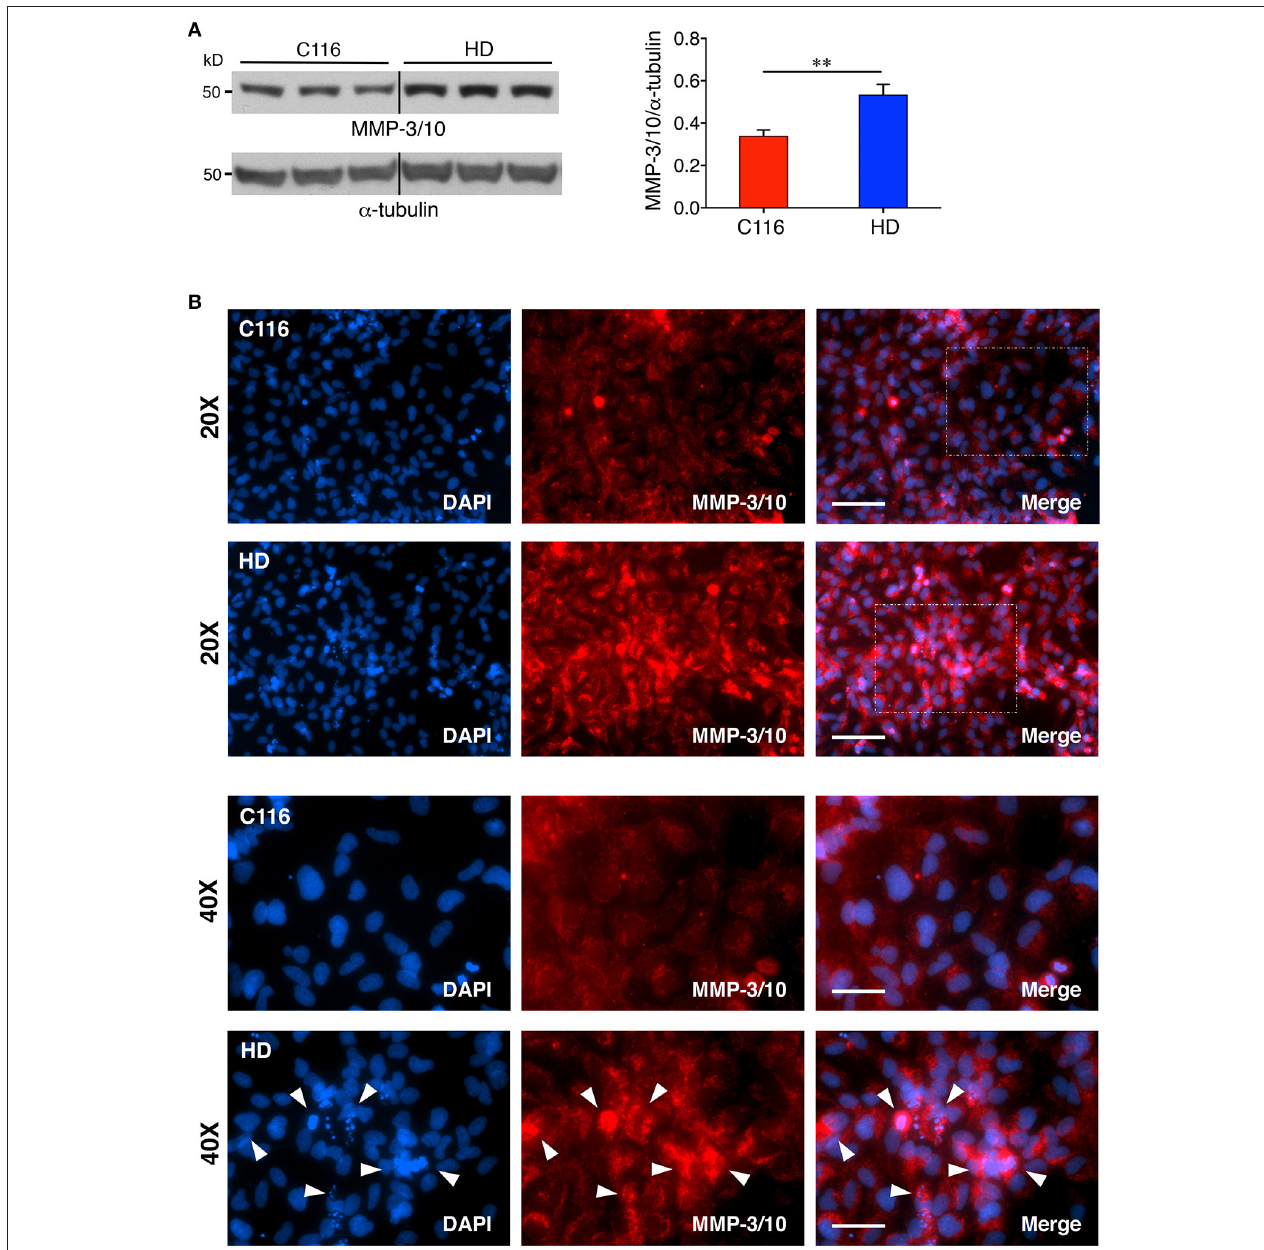
FIGURE 2 | MMP-3/10 expression is elevated in HD-NSCs. (A) Western blot analysis of MMP-3/10 reveals a robust increase in expression in HD-NSCs. MMP-3/10 immunoreactivity was quantified by densitometry and normalized for α -tubulin immunoreactivity ( n = 3 BR, ** p < 0.01; t -test). Error bars represent SD . (B) Immunofluorescence analysis confirms increased expression of MMP-3/10 in HD-NSCs, and also shows elevated nuclear presence of MMP-3/10 in HD-NSCs (40X magnified insets) as compared to C116-NSCs. Additionally, increased MMP-3/10 immunoreactivity is observed in apoptotic cells with degenerating nuclei